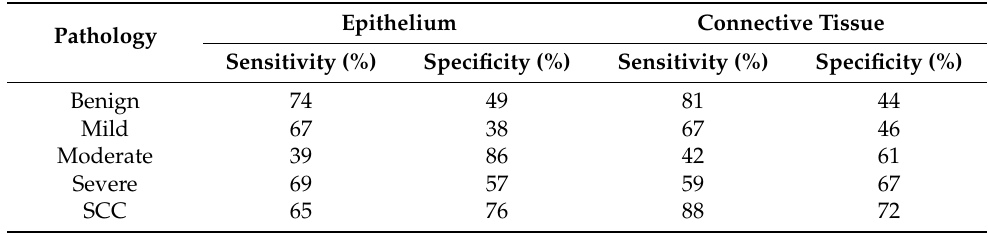
Table 2. Sensitivity and specificity values obtained from PLSDA classification with LOPOCV